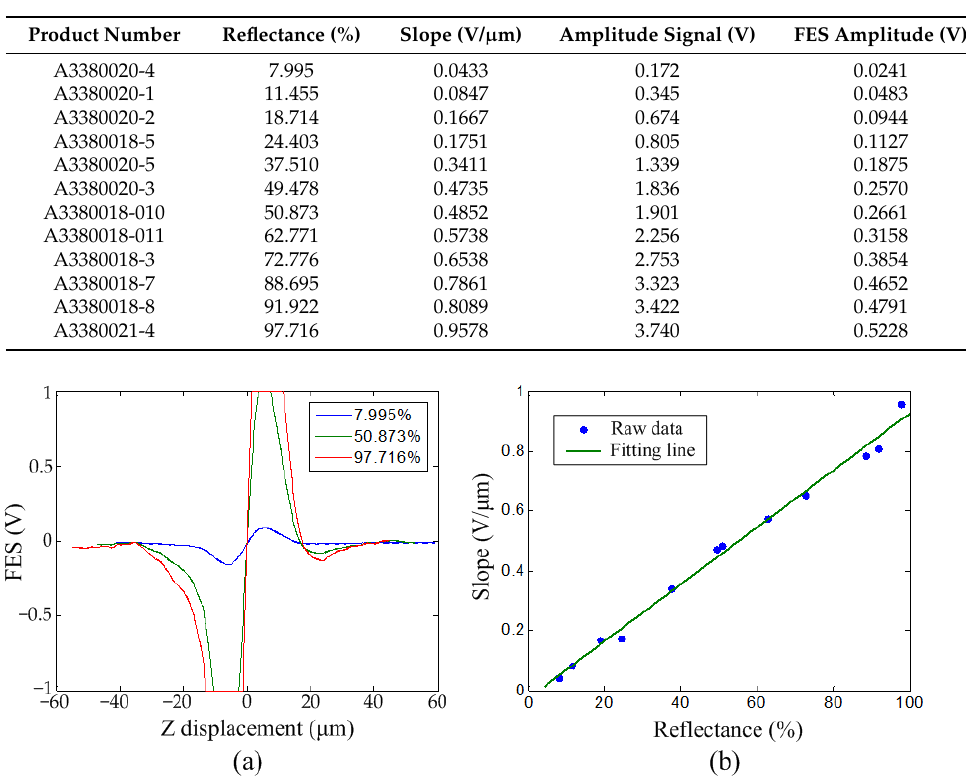
Table 1. Experimental results on the twelve optical filters with different reflectances.